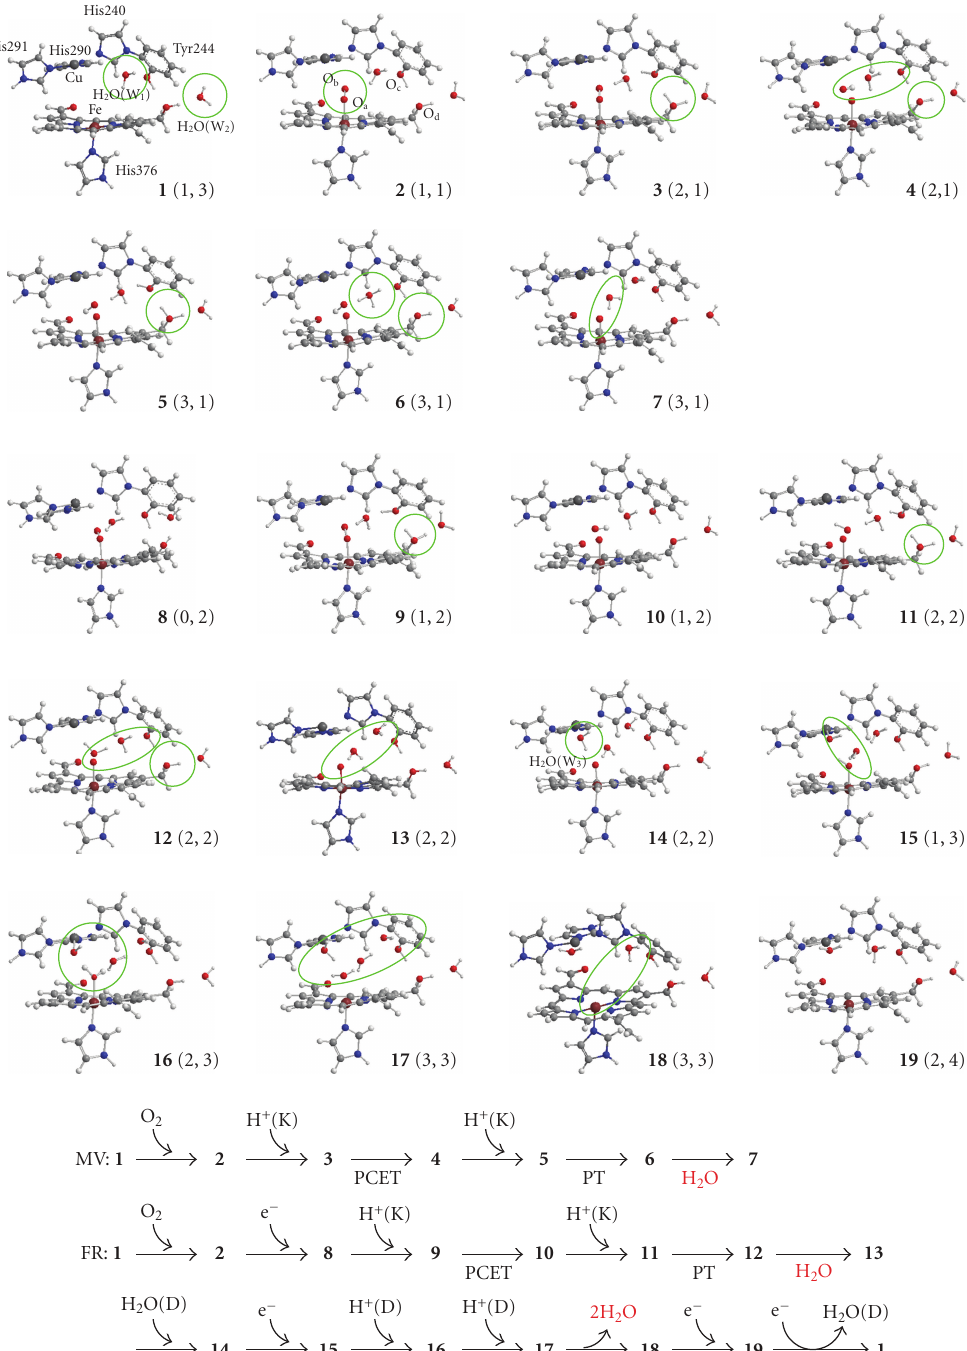
Figure 2: Geometries optimized on the pathways of the O 2 reduction at the catalytic sites in MV and FR C c Os, and the reaction paths of MV and FR C c Os examined in this